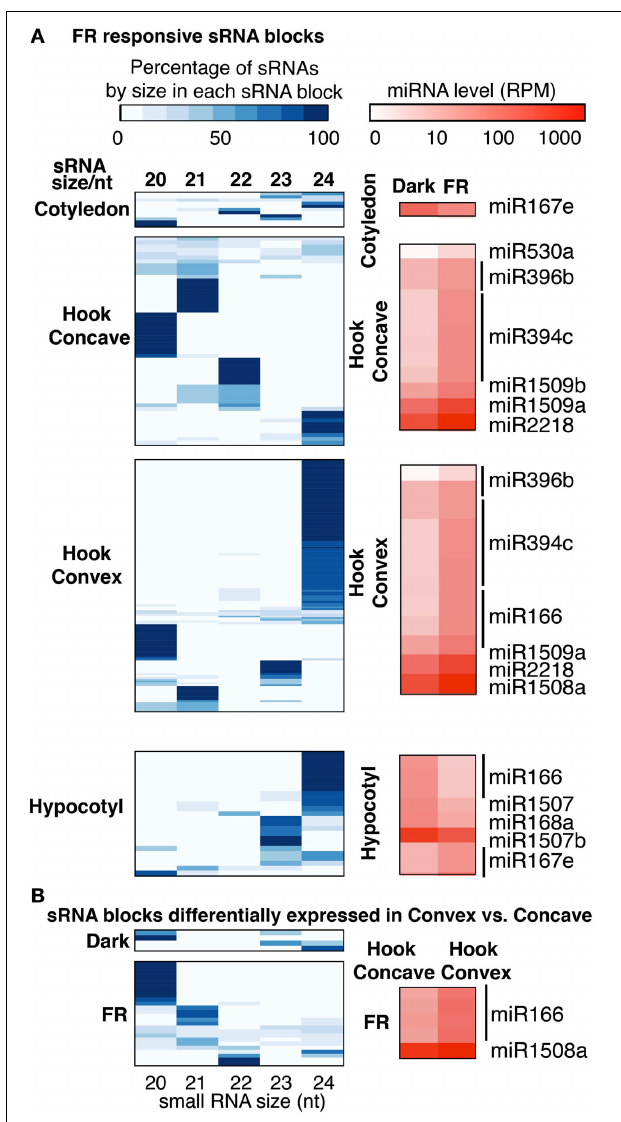
FIGURE 5 | (A) Size distribution of sRNAs and expression level of miRNAs in FR responsive sRNA blocks and (B) size distribution of sRNAs and expression level of miRNAs for sRNA blocks differentially expressed in the concave vs. convex side of the apical hook. The percentages of the total abundance of each small RNA species with lengths 20–24nt in differentially expressed blocks are shown in the white-blue heatmaps. The log10 expression levels of previously characterized miRNAs are shown in the white-red